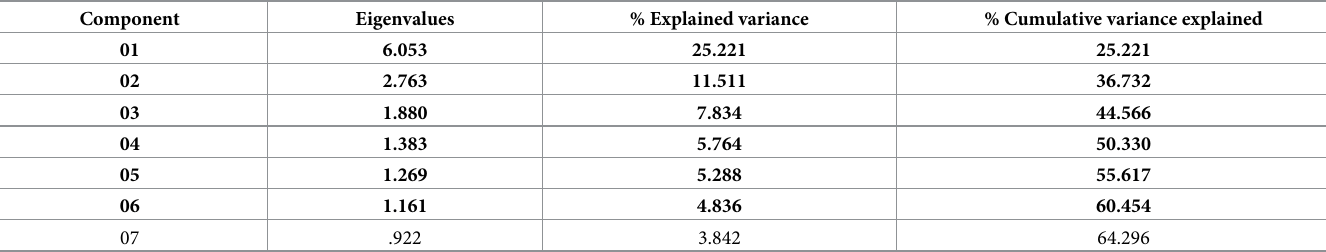
Table 1. Eigenvalues explained and accumulated variance of the GSAM